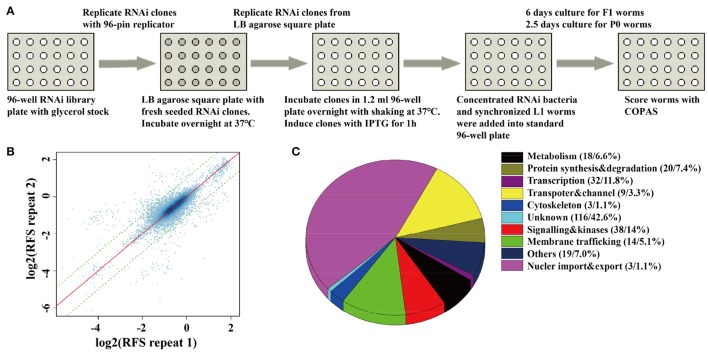
A whole-genome RNAi screen for genes required for synaptic vesicle cycling. (A) A schematic diagram of COPAS-based whole-genome RNAi screen. RNAi experiments for each clone were duplicated for whole genome screen or four replicates for the second validation screen. (B) The reproducibility of the whole genome screen data. The scatter plot shows the reproducibility of two repeats of each RNAi experiment in the whole genome screen. Each point indicates a RNAi experiment. The x axis and y axis are the log2 transformed median RFS (relative fluorescent signal) of the two repeats. The red line y = x indicates 100% repeatability. The two green lines y = x+1 and y = x−1 are the fold change of the two repeats are equal to 2. 97.9% of the points fall between the two lines. (C) The percentage distribution chart of candidate genes within indicated functional classes. The total number of genes in each group and its percent to the total number of candidate genes are indicated in the parenthesis. 272 candidate genes were found for synaptic vesicle cycling after multi-round RNAi screen (Tables S2, S3).